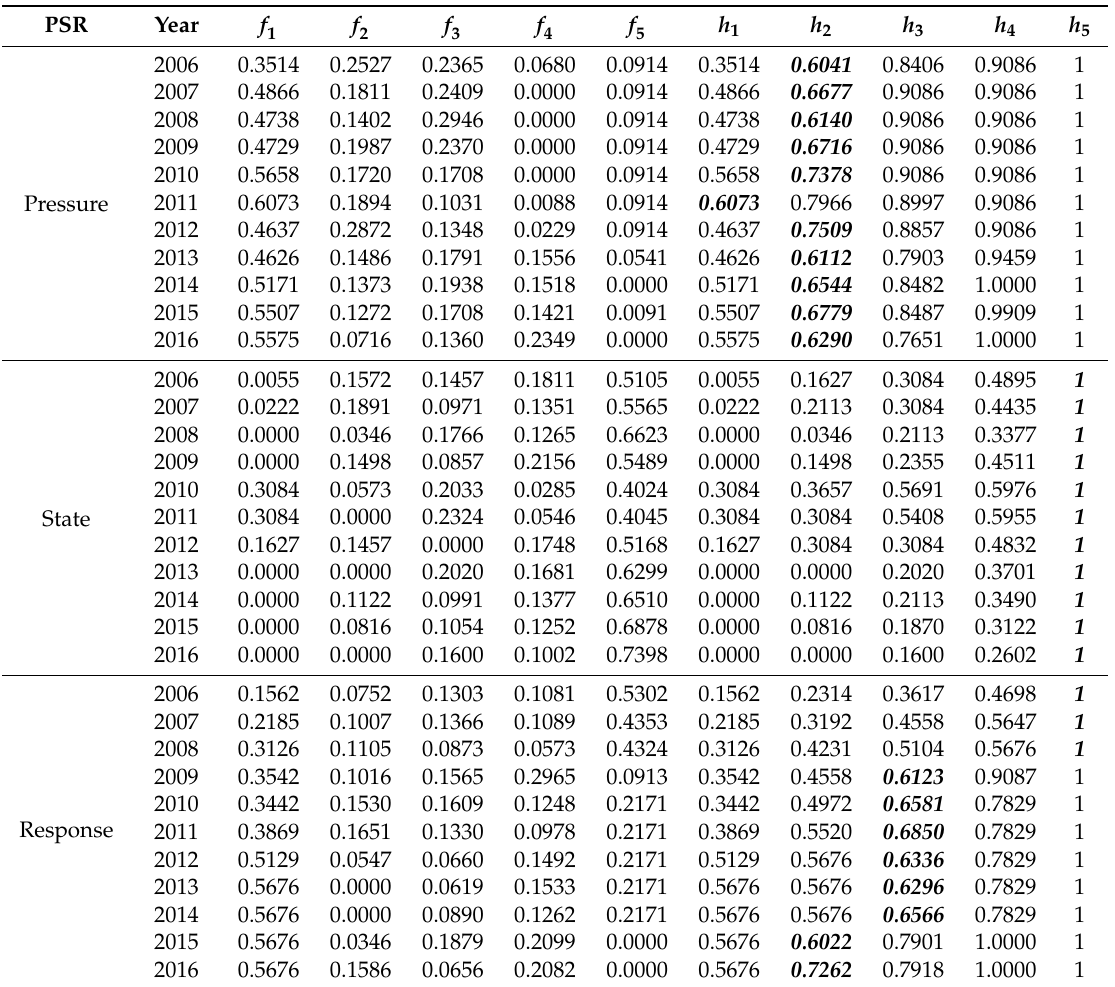
Table 5. Total connection degree and cumulative connection degree of PSR subsystems of water resources